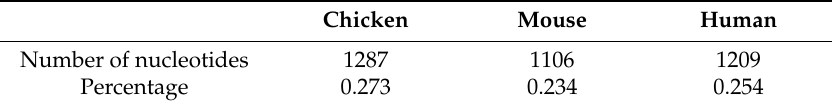
Table 1. Intronic Zebrafish nucleotides conserved in Chicken, Mouse and Human.